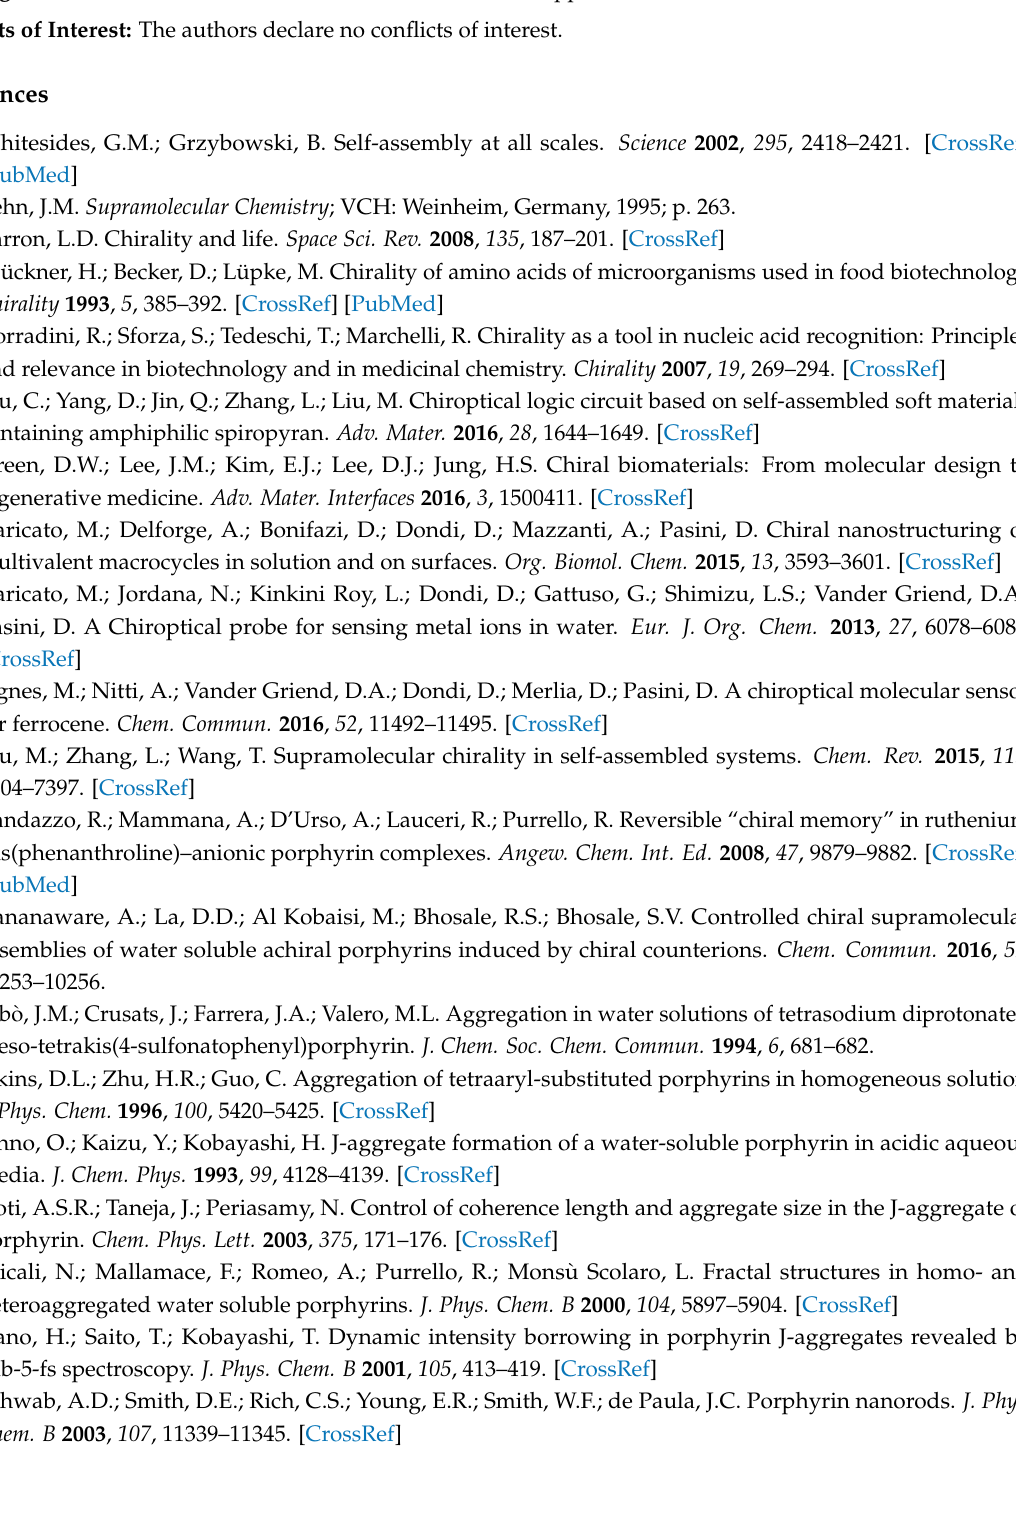
Figure S4: CD spectra of H 4 TPPS4 J-aggregates obtained using the procedure acid last . Figure S5: UV Vis spectra of Lys/H 2 TPPS4 complex preparation using the procedure acid first . Table S1: pKa values and structures of the amino acids. Figure S6: ICD vs IEP for each amino acid with both procedures’ acid first and acid last